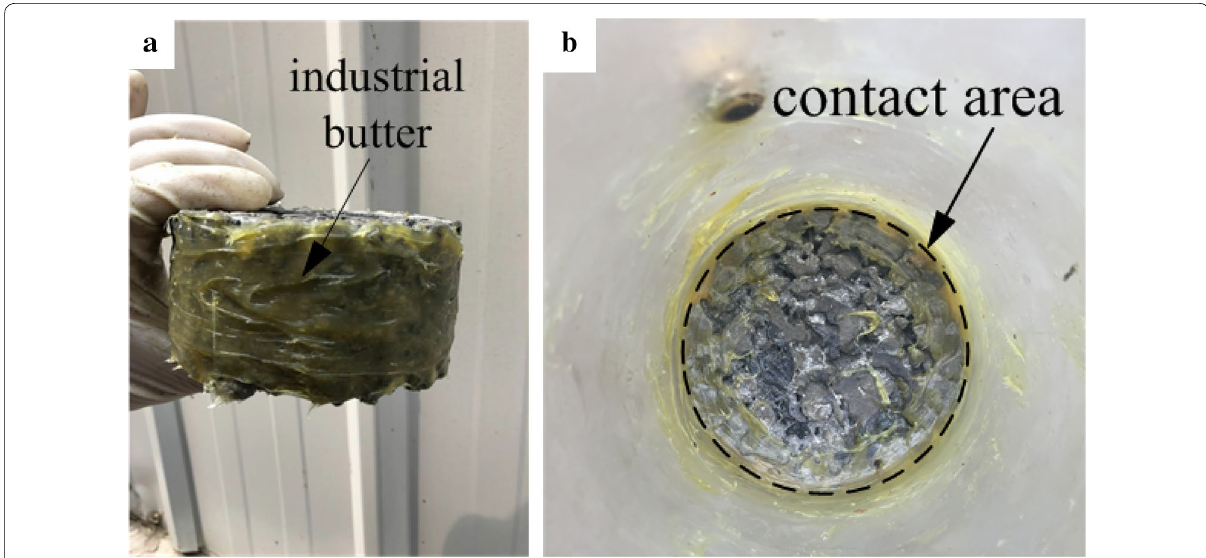
Fig. 3 Specimens smeared with industrial butter on the a side of specimens, and b top perimeter of